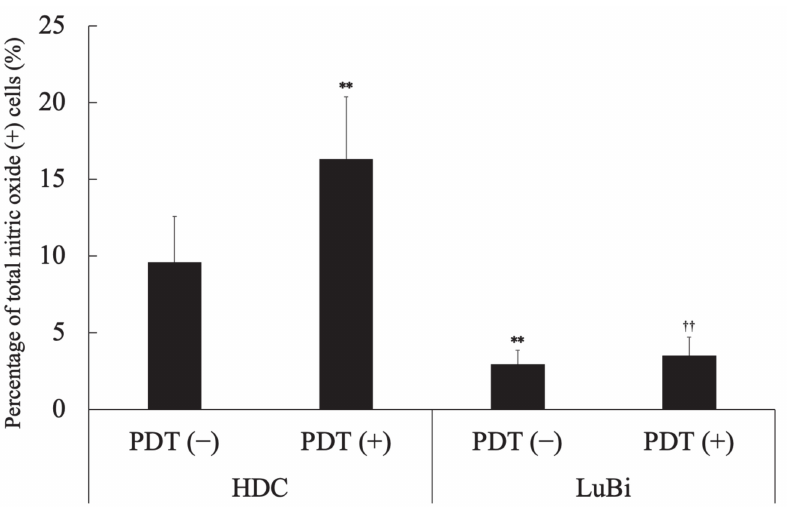
Figure 7. Analysis of nitric oxide (NO)-positive cells. NO generation was assessed before and 4